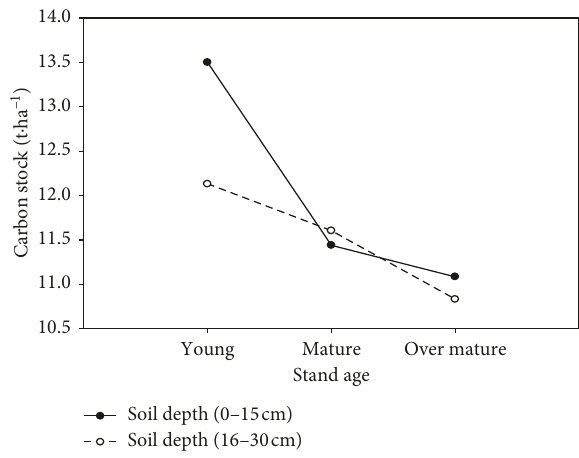
Figure 3: Soil carbon stock in young, mature, and overmature stand at 0–15cm and 15–30cm depth increment.